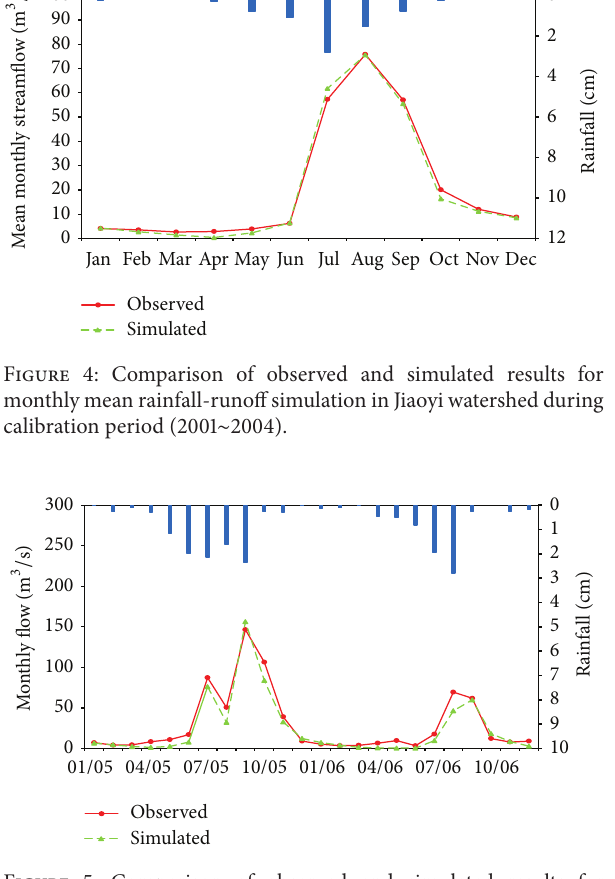
Figure 5: Comparison of observed and simulated results for mean monthly rainfall-runoff simulation in Jiaoyi watershed during validation period (2005 ∼ 2006).